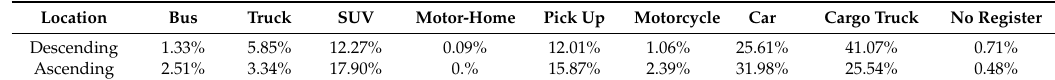
Table 6. Accidents for type of vehicle.